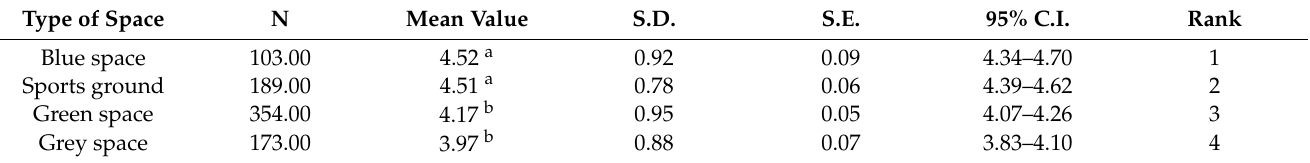
Table 2. ANOVA with a post hoc test on recovery values among the four study